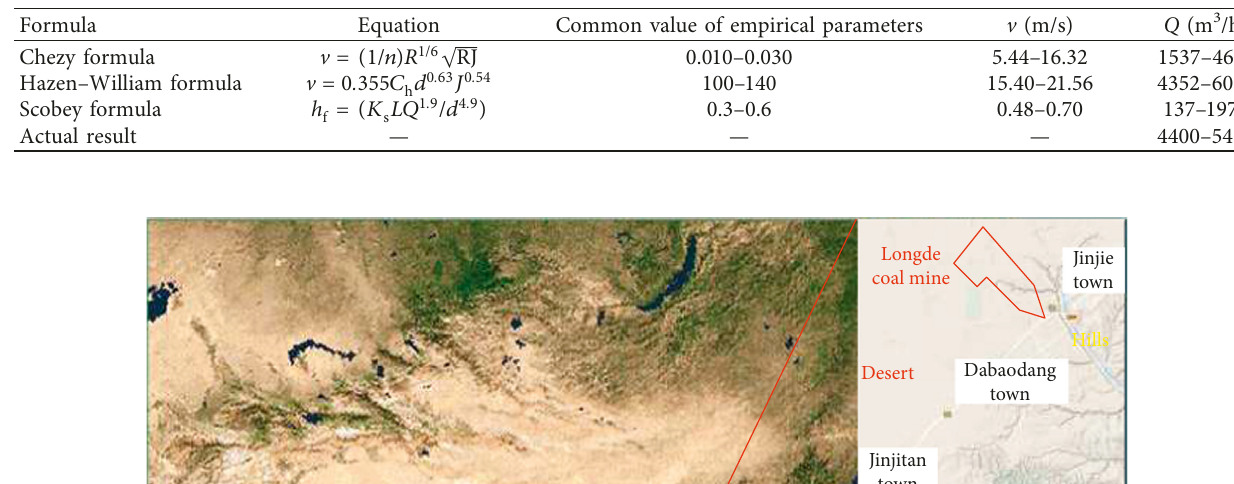
Table 1: Empirical formula and calculation result